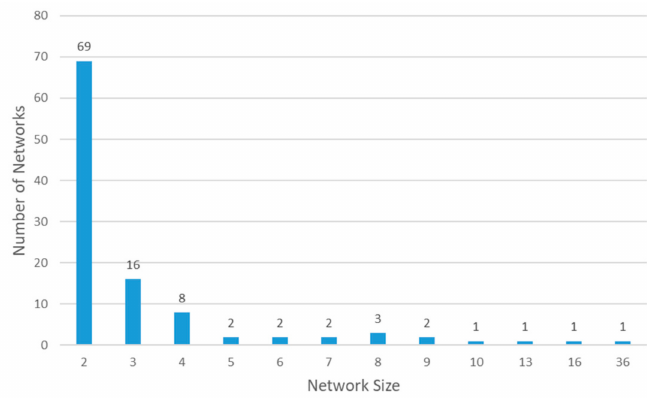
Figure 3. Histogram: network size of viral